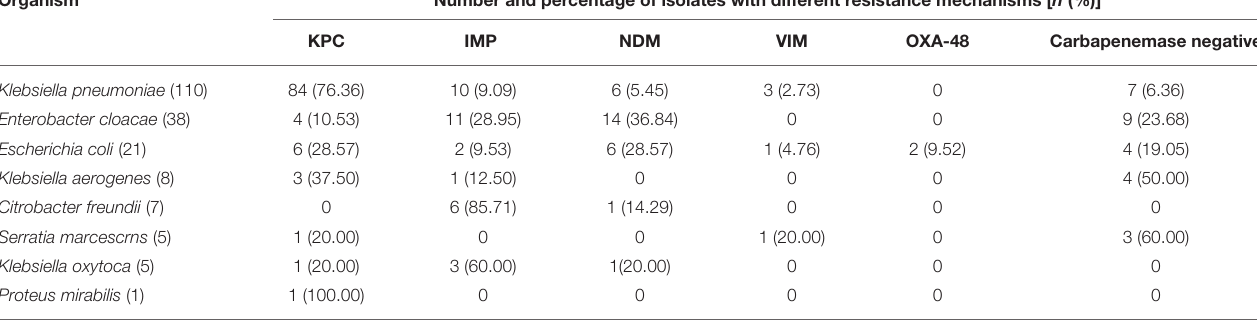
TABLE 1 | The enzyme type and strain types of 195 CRE strains. Organism